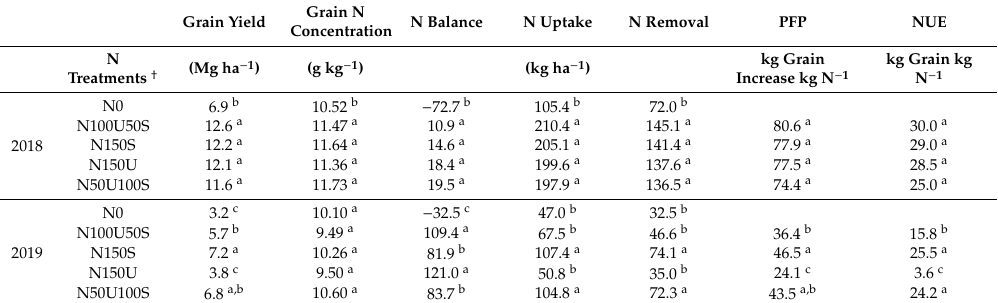
Table 2. Corn grain yield and nitrogen (N) concentration, N balance and removal, partial factor productivity (PFP), and N use e ffi ciency (NUE) as a ff ected by di ff erent N rates in 2018 and 2019 growing seasons. Grain Yield Grain N Concentration N Balance N Uptake N